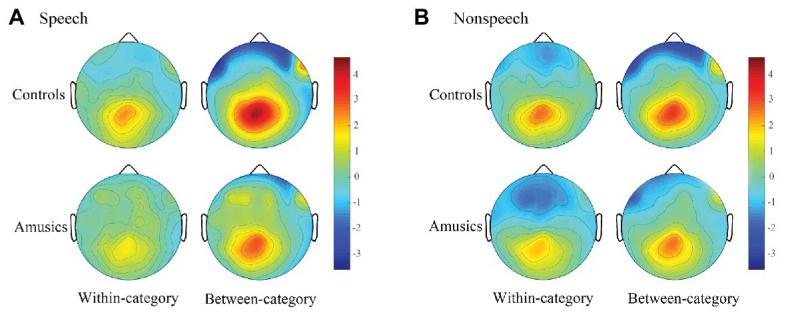
Topographic maps in speech (A) and nonspeech (B) contexts which demonstrate the scalp distributions of the P300 amplitudes (320–600 ms) of within-category and between-category difference waves (deviants minus standards) across the controls and amusics.